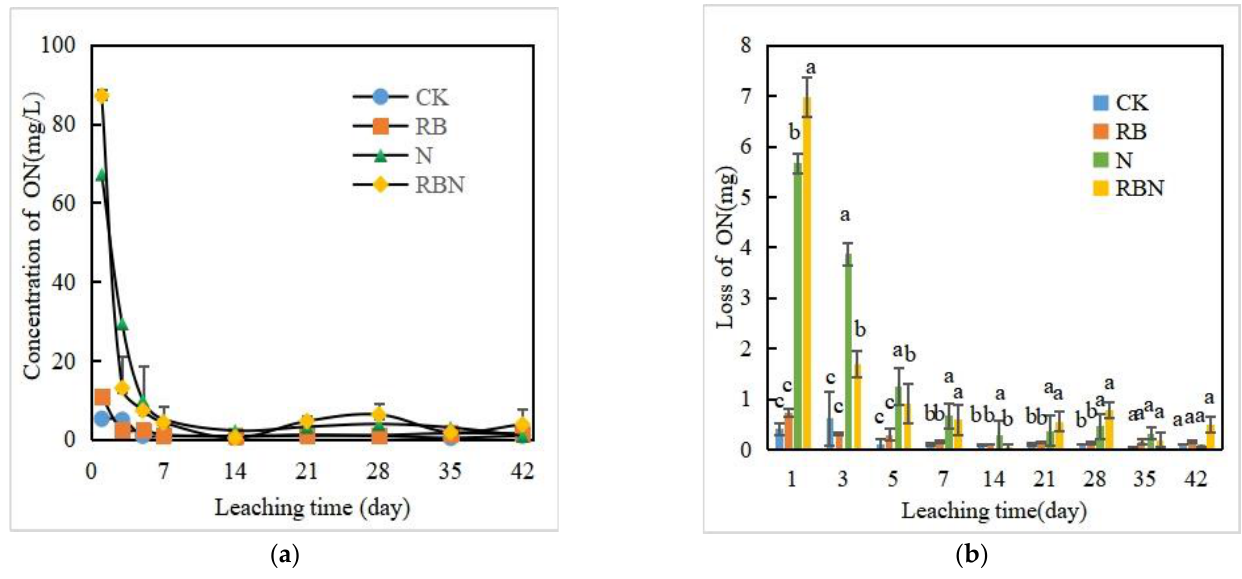
Figure 4. ( a ) Concentration of ON in leachate; ( b ) loss of ON in leachate. Different letters in the ( b ) indicate significant differences between treatments ( p < 0.05).